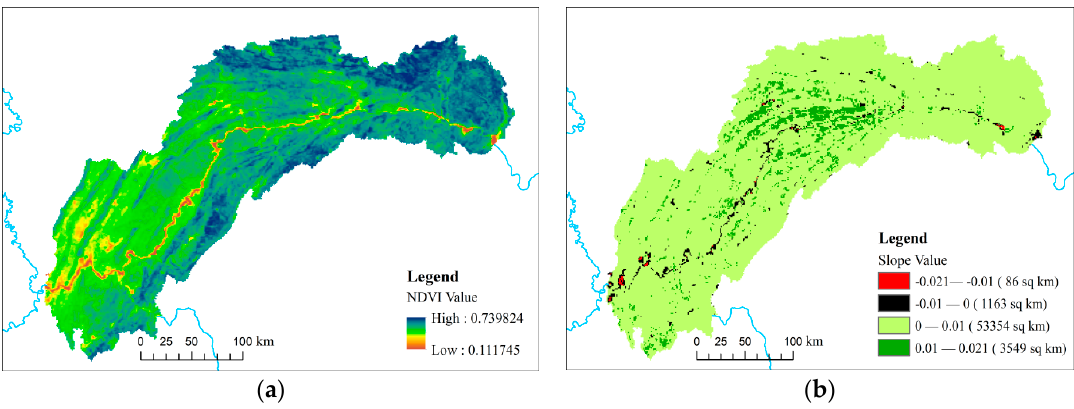
Figure 5. Spatial distribution and interannual change slope of NDVI in the TGR intervening basin: ( a ) distribution of annual average NDVI; ( b ) NDVI interannual change slope classification.